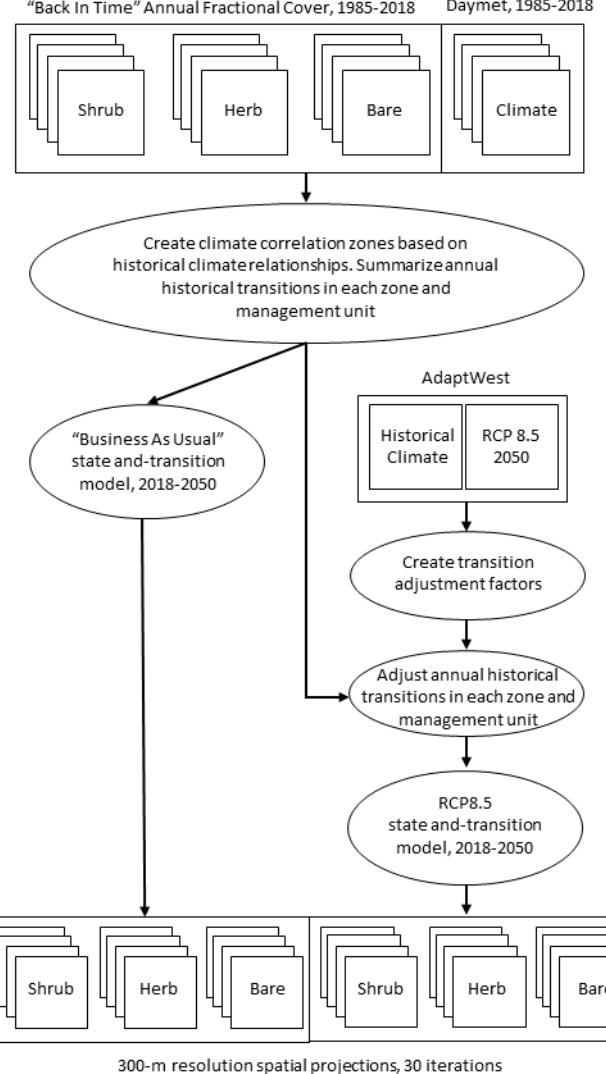
Figure 2. An overview of the methods applied to generate spatially explicit land-cover projections from 2018–2050 in Hart Mountain NAR, Beaty Butte HMA, and Sheldon NWR.